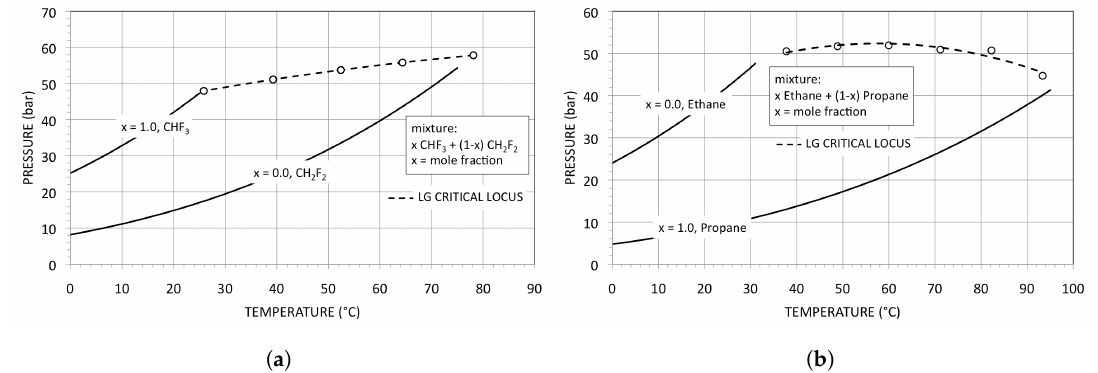
Figure 9. ( a ) Liquid–gas (LG) critical loci for binary mixtures of refrigerants HFC-23 (CHF 3 ) and HFC-32 (CH 2 F 2 ). Data are from [28]; ( b ) LG critical loci for binary mixtures of ethane and propane. Data are from